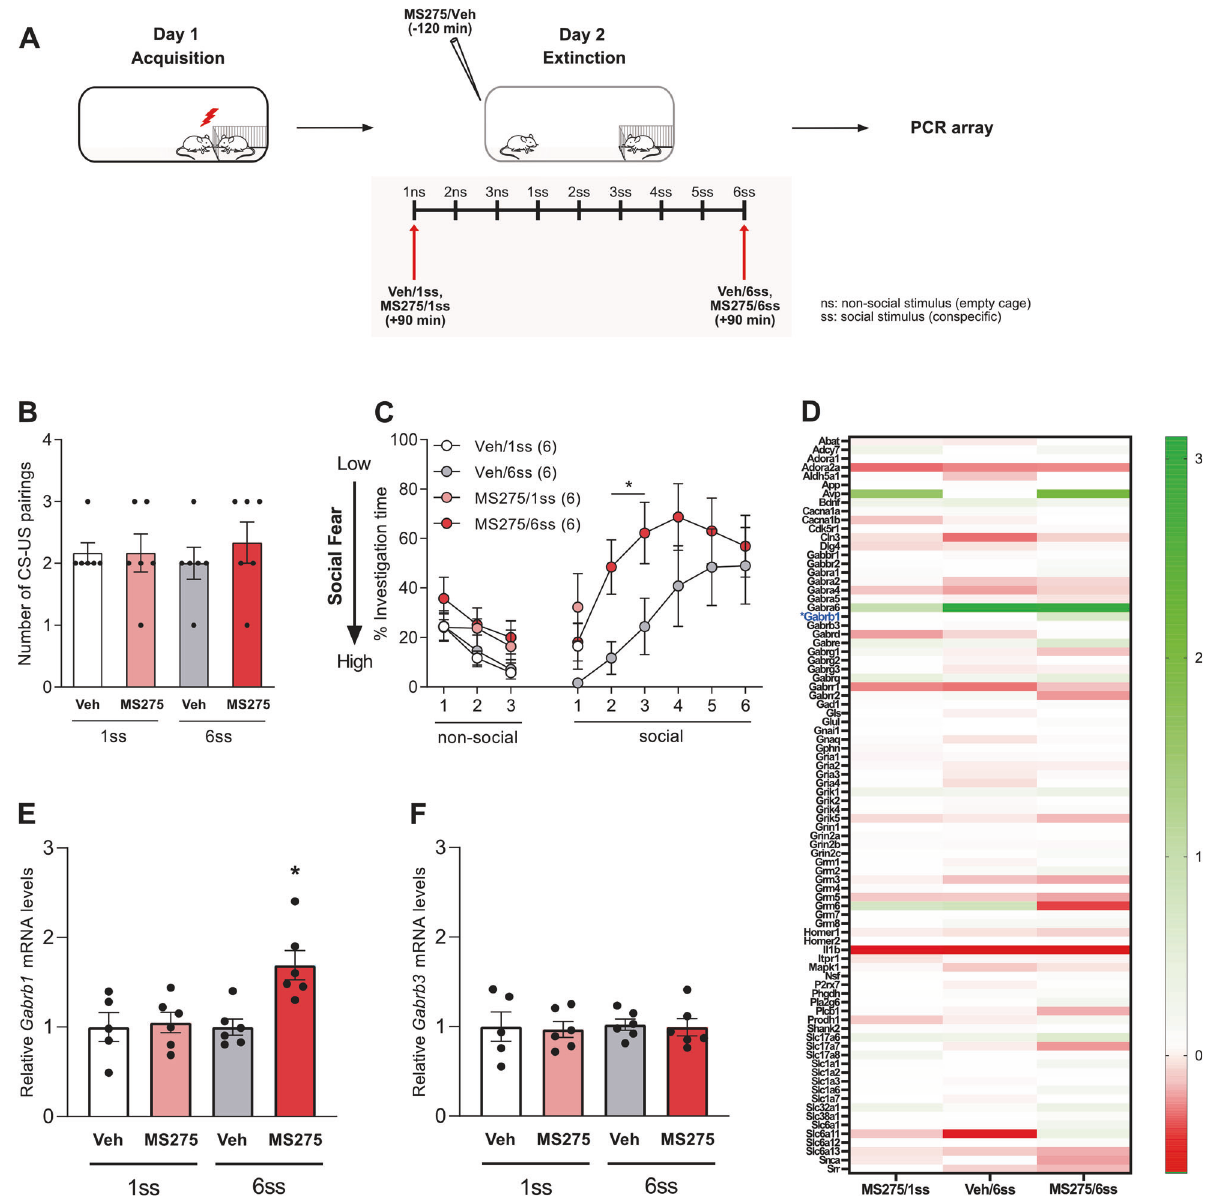
Fig. 3 Inhibition of HDAC1 with the lateral septum (LS) leads to dynamic changes in the expression of genes related to GABA and glutamate signaling. Schematic representation of the experimental timeline wherein red arrows indicate the time point of sacri fi ce ( A ). Mice were fear conditioned on day 1 of the SFC paradigm. The number of CS-US pairings for all groups of conditioned (SFC + ) mice ( B ). SFC + mice were bilaterally infused with vehicle (Veh; Ringer; 0.2 µl/hemisphere) or MS275 (375 ng/0.2 µl/hemisphere) 120 min before social fear extinction ( C ). Total mRNA isolated from septum 90 min either after abridged (Veh/1ss and MS275/1ss n = 5 – 6/group) or complete (Veh/6ss and MS275/6ss; n = 6/group; C ) social fear extinction was used for PCR array analysis, which assessed genes associated with GABA and glutamate signaling (normalized against Veh/1 ss; Heatmap; D ). Relative gene expression of Gabrb1 ( E ) and Gabrb3 ( F ) within the LS of SFC + mice treated with Veh or MS275 and exposed to 1ss or 6ss. Data represent mean CS-US pairings ± SEM ( B ), mean investigation time ± SEM ( C ), relative mRNA levels ± SEM ( E , F ). * P < 0.05 MS275/6ss vs. Veh/6ss and MS275/6ss vs. all other groups ( E equal acquisition (Fig. 5E) and exhibited similarly low social investigation during exposure to the 1st social stimulus during extinction training (Fig. 5F). However, as in the previous experiment (Fig. 4C), the SFC + /Muc group had an accelerated social fear extinction ( P < 0.05 vs. SFC + /Veh; Fig. 5F). Interestingly, during long-term recall on day 32, SFC + /Muc mice showed increased social investigation compared to the SFC + /Veh group ( P < 0.05 vs. SFC + /Veh; Fig. 5G), suggesting that LS-GABA-A activation also results in enhanced long-lasting extinction memory.